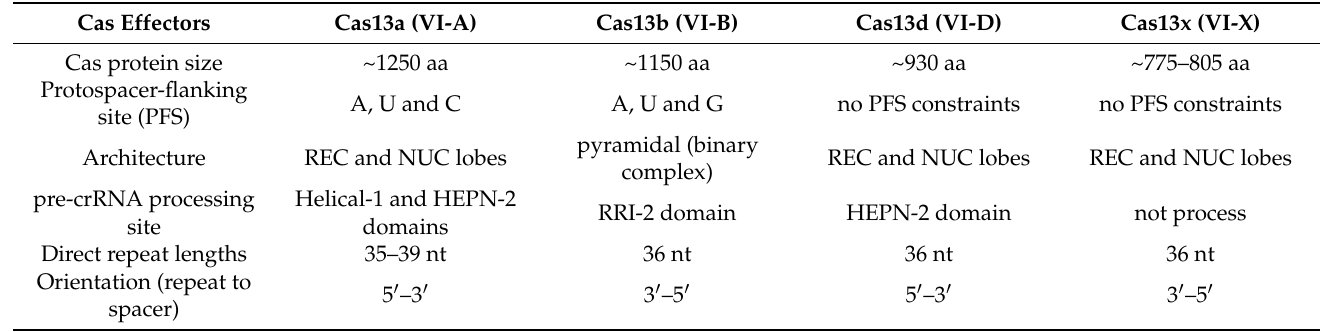
Table 2. Characteristics of Cas13 effectors in type VI CRISPR